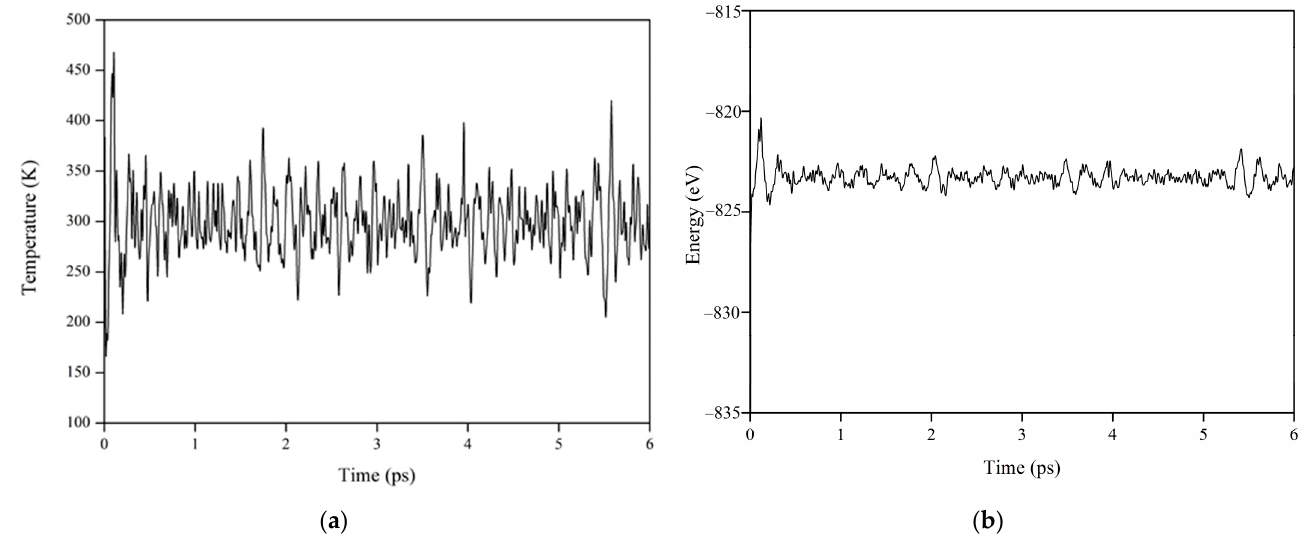
Figure 2. Variation of ( a ) temperature and ( b ) total energy with time for La 2 Zr 2 O 7 with 0.3% electron excitation.